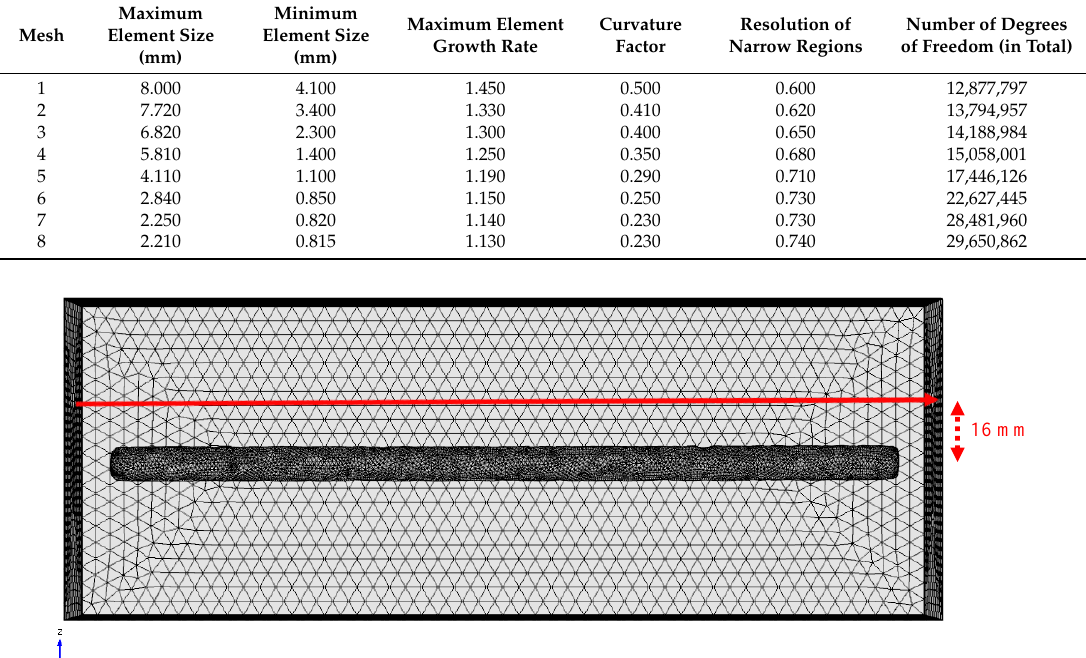
Figure 11. Path of data recording (with distance 16 mm from center of the rebar). 5959.259.459.659.860 Figure 12. Maximum values of Z-component magnetic flux density, from 295.0592 mm to 307.0592 mm (values related to Hole 2), for different box mesh specifications with fixed rebar mesh #8 (Table 4).